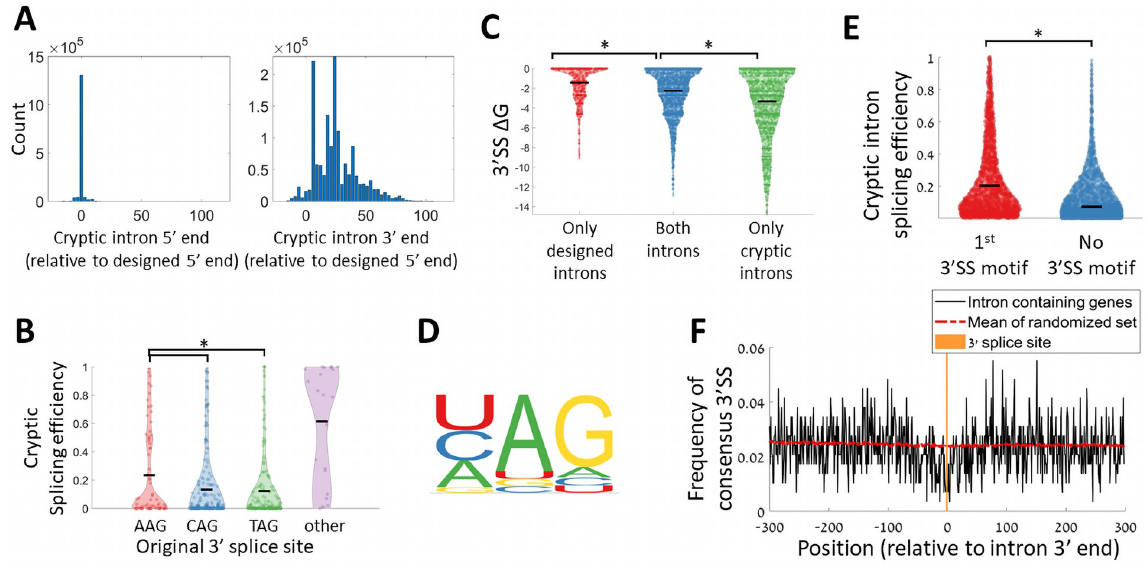
Fig 5. Cryptic splice isoforms are produced due to selection of alternative 3’SS. A. Relative splice site position distribution for cryptic introns (relative to the designed splice site position), for the 5’ splice site (left), and the 3’ splice site (right). B. Distribution of cryptic isoforms splicing efficiency for the set of natural introns, binned according to the original intron’s 3’SS. Introns utilizing AAG 3’SS have significantly higher cryptic splicing efficiency values (t-test p-value < 0.005) C. Distribution of predicted Δ G values at a window of 30 nucleotides around the designed 3’SS for variants with designed splice isoform and no cryptic splice isoform (red), variants with both designed and cryptic splice isoform (blue), and variants with only cryptic splice isoform (green). The difference between all three distributions is significant (t-test, p- value < 10 − 18 ). D. Sequence motif of the 3’SS for all cryptic intron isoforms detected. E. The distribution of splicing efficiency for cryptic splice isoforms, binned according to isoforms in which the cryptic intron is spliced at the first appearance of a 3’SS motif (red), or isoforms for which the last 3 nucleotides of the introns are not a 3’SS motif (blue). (t-test, p-value < 10 − 100 ). F. 3’SS motif avoidance pattern around introns’ 3’ end in the S . cerevisiae genome. All S . cerevisiae intron-containing genes were registered according to the 3’ end of their intron. The black line presents the frequency of TAG/CAG motif for each position. The red dashed line presents the expected frequency by averaging the motif frequencies over 1000 sets of sequences registered according to random positions inside coding genes. Orange vertical line represents the position of the 3’SS.